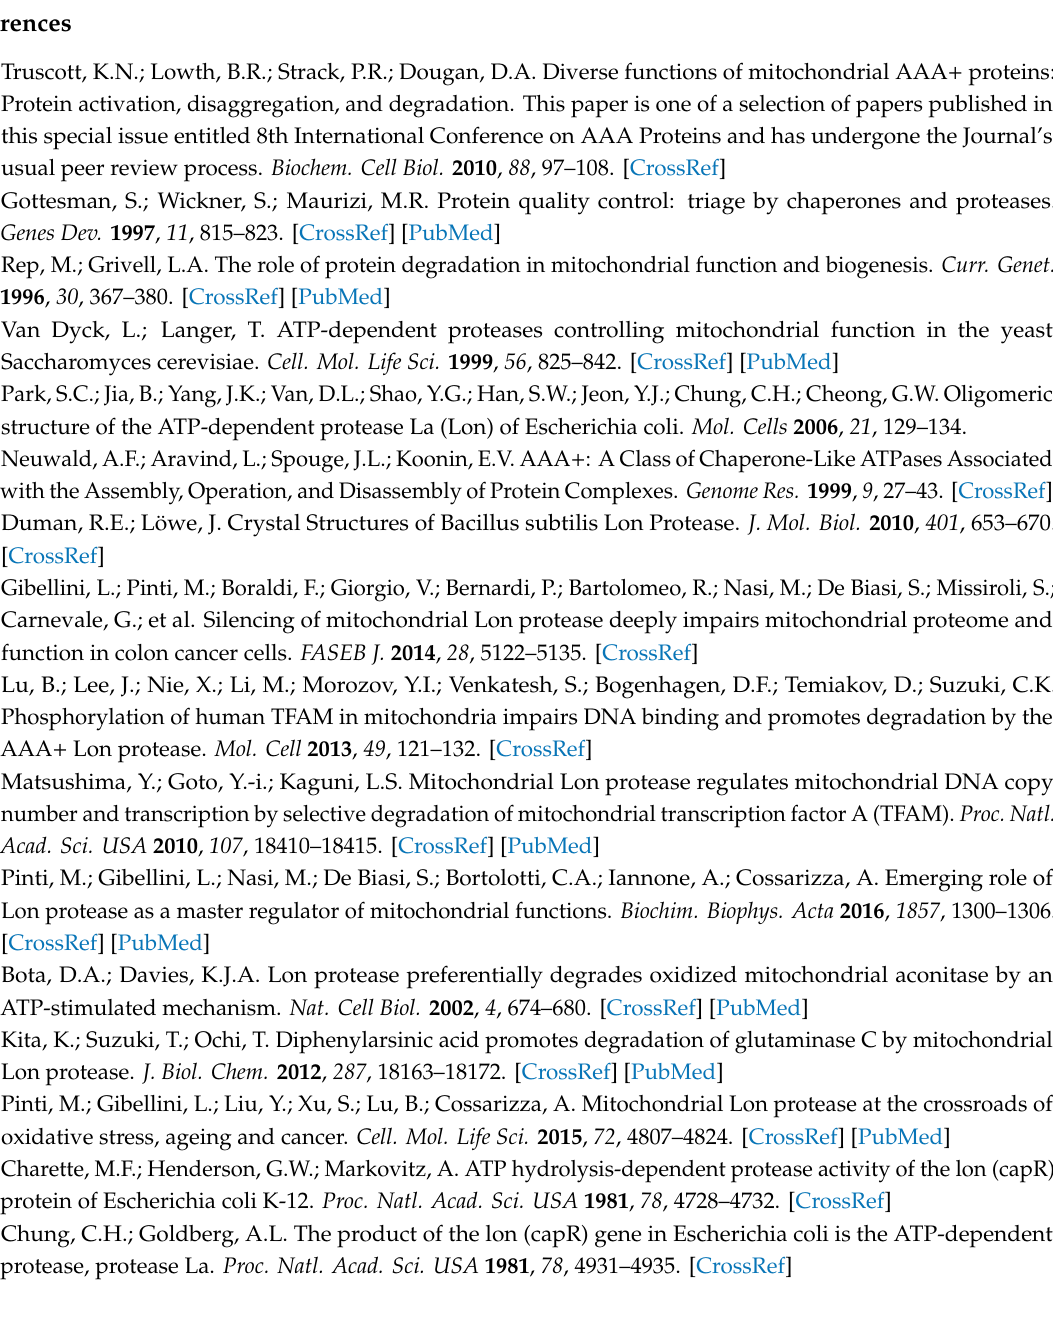
Figure S4: Cell growth curves of wt (circle) and het (square) MEFs. Figure S5: TFAM expression in MEFs as revealed by western blot. Figure S6: Analysis of the relative protein expression of ACO2, SOD2 and GRP75 in MEFs from wt and het mice as revealed by western